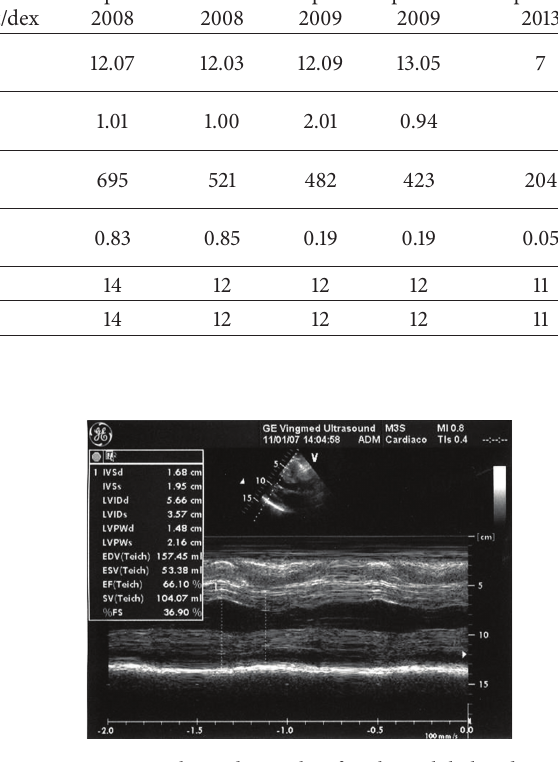
Figure 3: Case 2; echocardiography after the melphalan/dexameth- asone